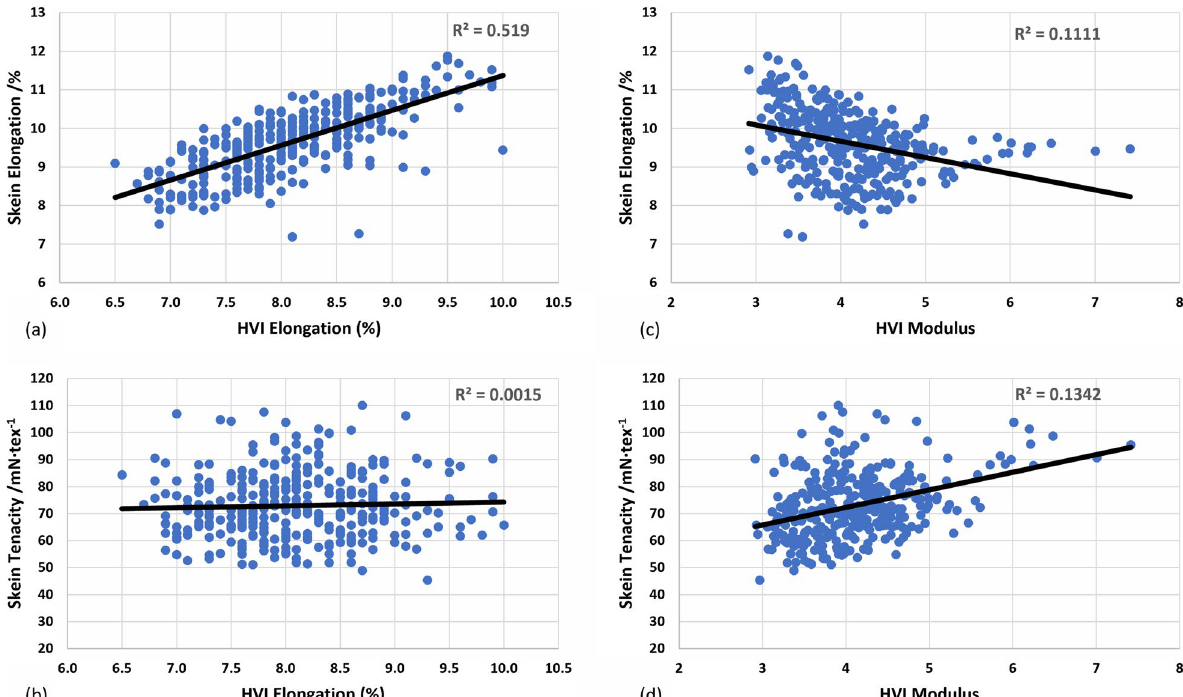
Fig. 2 a HVI Elongation (%) vs Skein Elongation (%). b HVI Elongation (%) vs Skein Tenacity (mN/tex). c HVI Modulus vs Skein Elongation (%). d HVI Modulus vs Skein Tenacity